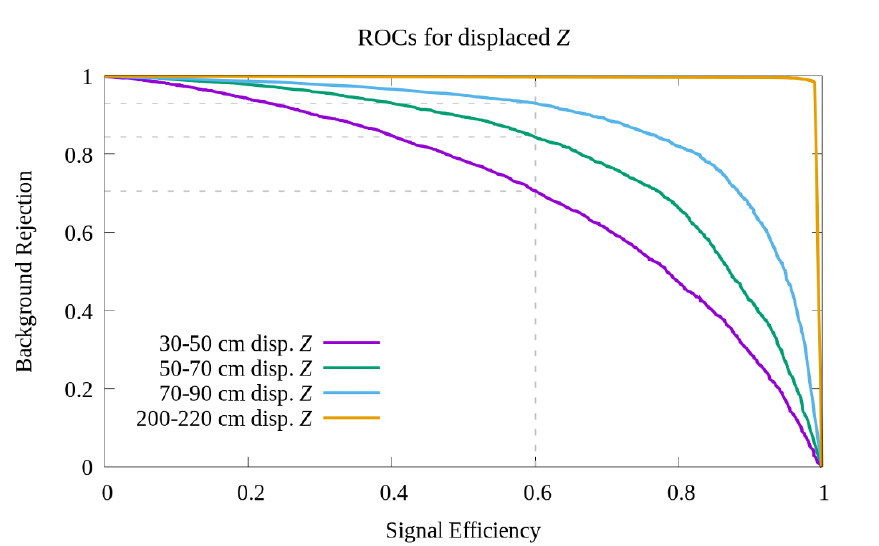
Figure 9. ROCs of the CNN performance to separate non-displaced Z from di(cid:11)erent classes of displaced Z